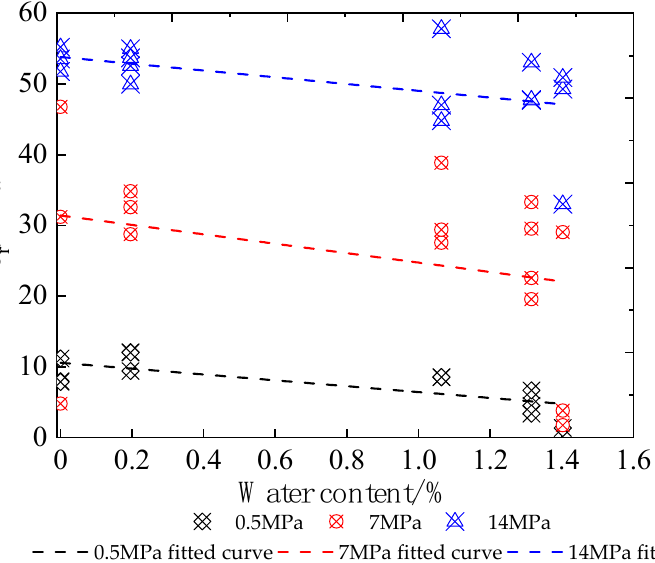
Figure 7. Relationship between different water contents and residual strengths.